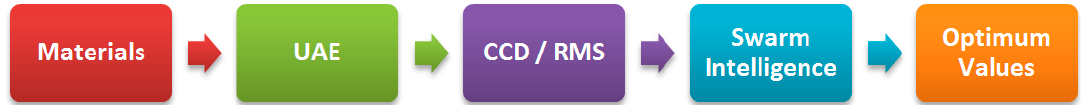
Figure 1. General scheme of the solution approach in this study. UAE: ultrasonic-assisted extraction; CCD: central composite design; RMS: Response surface methodology.